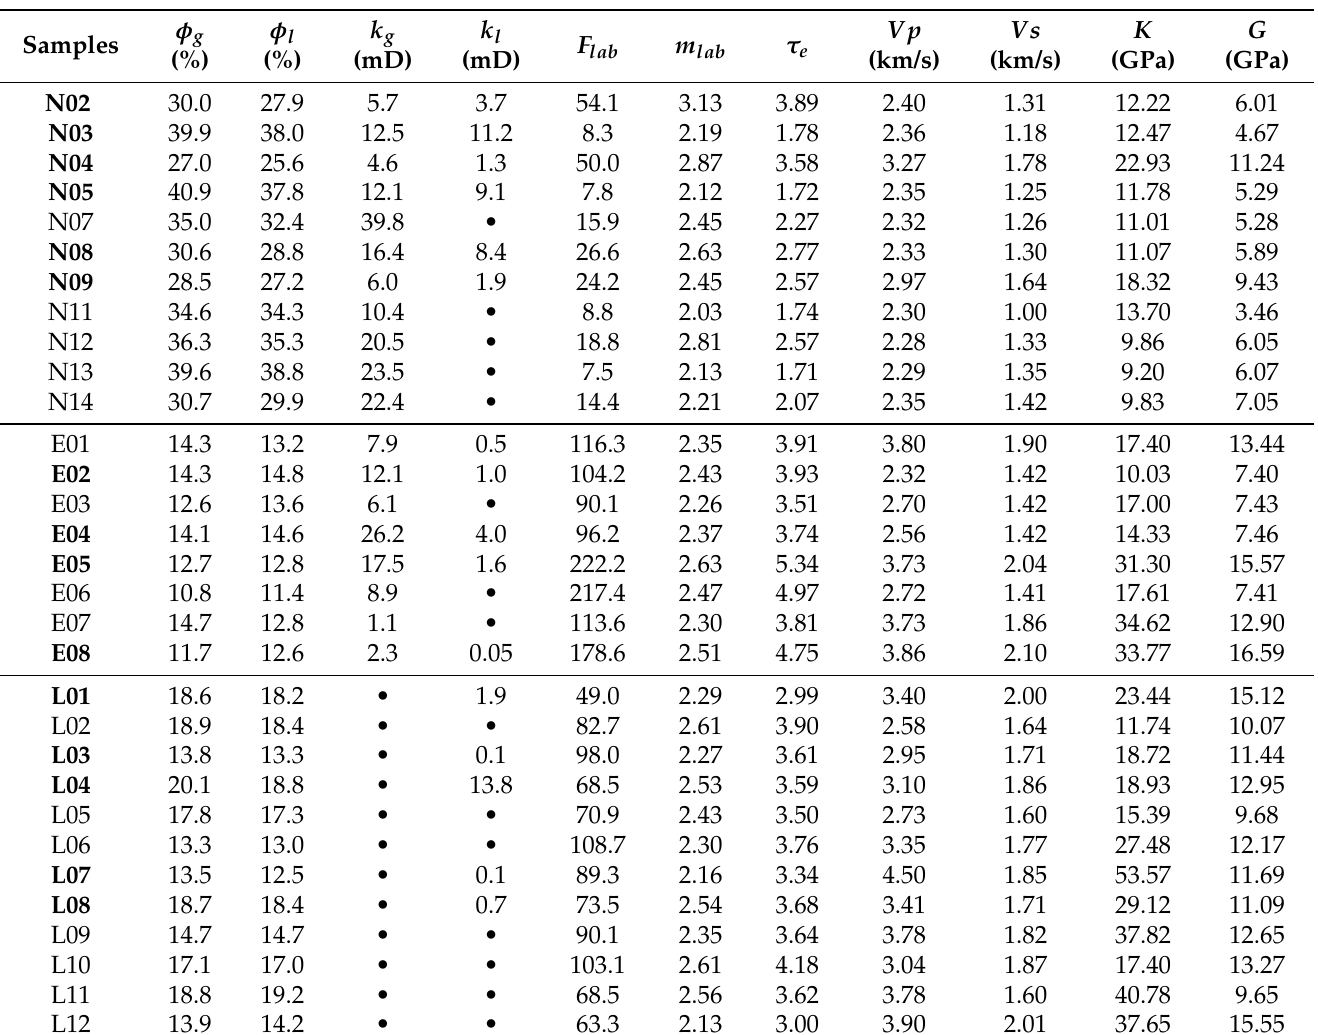
Table 1. Petrophysical parameters summary from laboratory measurements: gas porosity φ g (%), liquid porosity φ l (%), gas permeability k g (mD), liquid permeability k l (mD), formation factor F lab , cementation index m lab and electrical tortuosity τ e , P wave velocity Vp (km/s), S wave velocity Vs (km/s), Bulk modulus K (GPa), Shear modulus G (GPa). Imaged